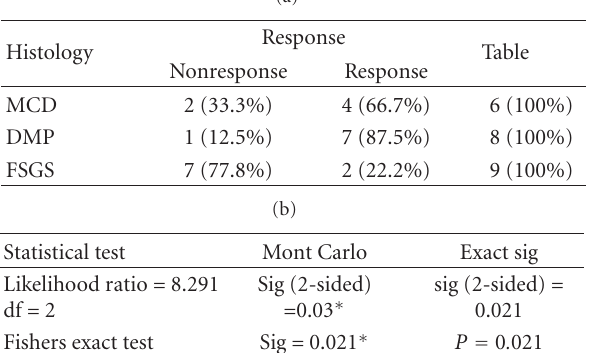
Table 4: Frequency of response to MMF + cyclosporine A based on histological